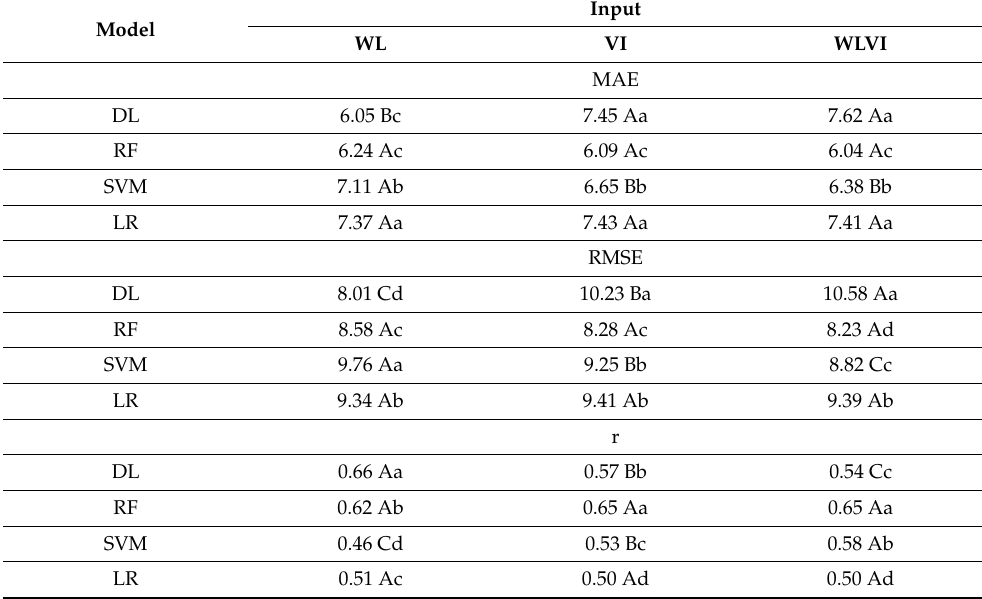
Table 2. Grouping of means of mean absolute error (MAE), root mean squared error (RMSE), and Pearson’s correlation coefficient (r) between estimated and observed values for days to maturity in soybean obtained with different machine learning models and input